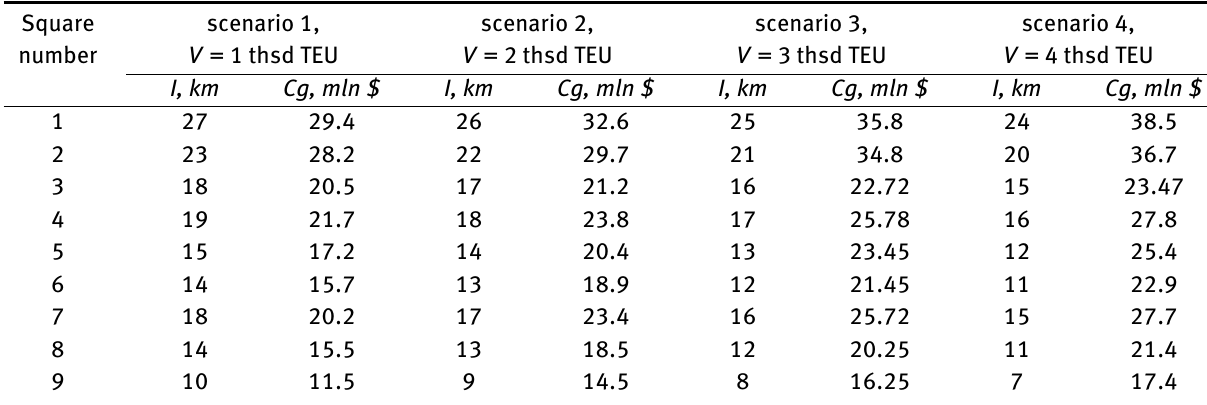
Table 2: Model values of main parameters of dry port.